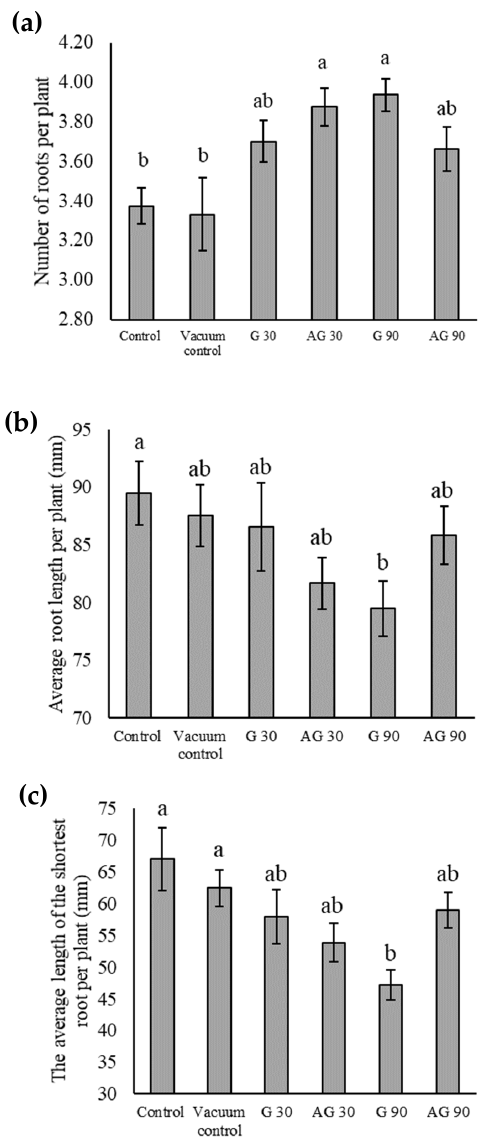
Figure 9. The average number of roots per seedling ( a ), the average root length per seedling ( b ), and the average length of the shortest root per seedling ( c ) in untreated (Control) seeds, seeds exposed to vacuum (Vacuum control), and CP-treated seeds in the glow regime for 30 (G30) or 90 s (G90), and in the afterglow regime for 30 (AG30) or 90 s (AG90). Displayed values are the mean ± SE of three replications. Different letters (a,b) indicate statistically significant differences among treat- ments according to Duncan’s test ( p < 0.05).